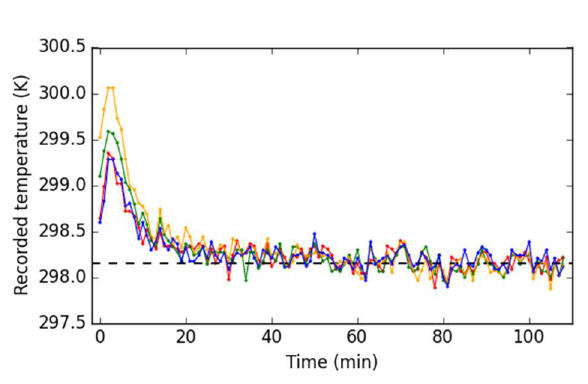
Figure 8. Corrected temperature readings over time of a blackbody at 298.15 K (dashed line), at sample pixels from the image centre (blue), top left corner (orange), top right corner (red), and bottom right corner (green).